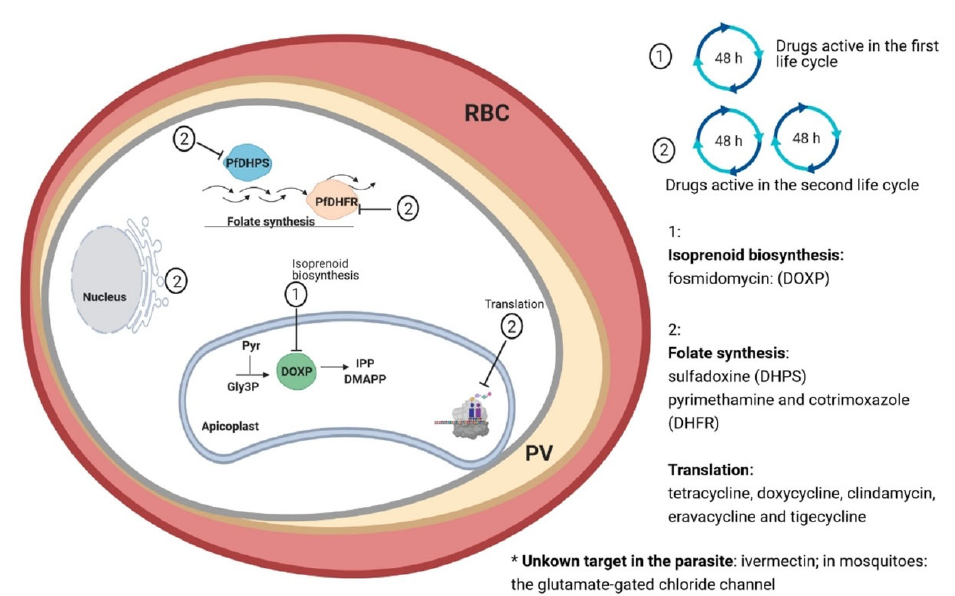
Figure 2. Targets of antibiotics with antiplasmodial activity.